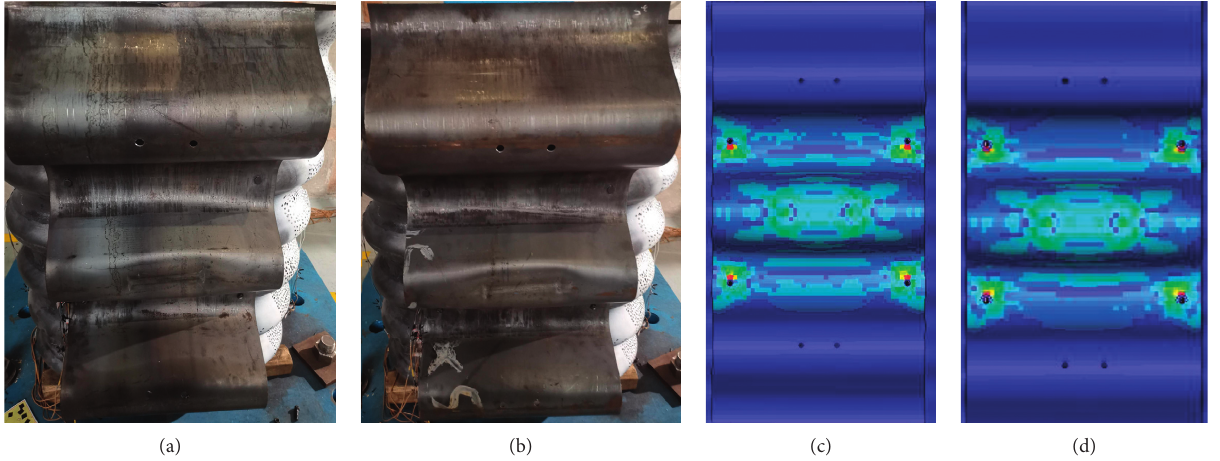
Figure 6: Deformation modes of experiment and simulation: (a, b) deformation modes of experiment, (c) the bolt is simplified to beam +rigid body; and (d) the bolt is simplified to mass+rigid